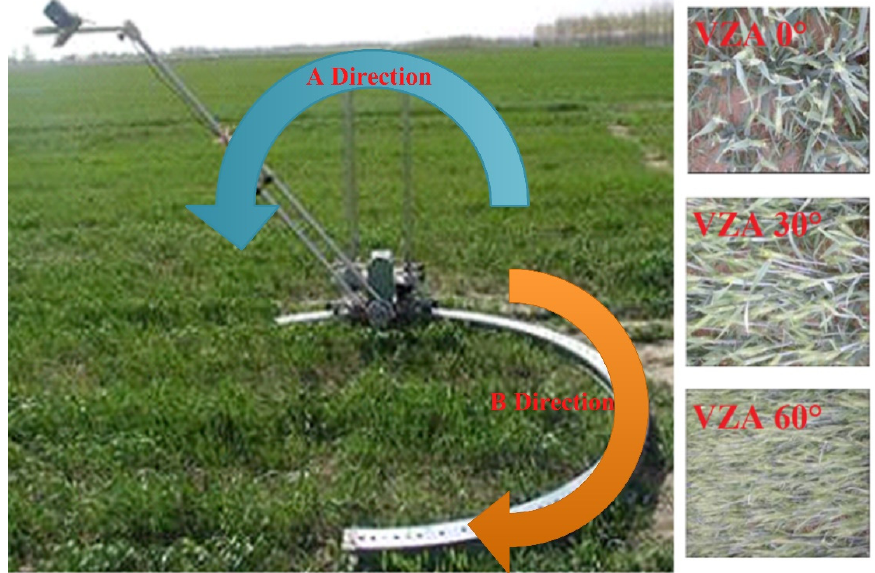
Figure 1. Photo of multi-angular observation